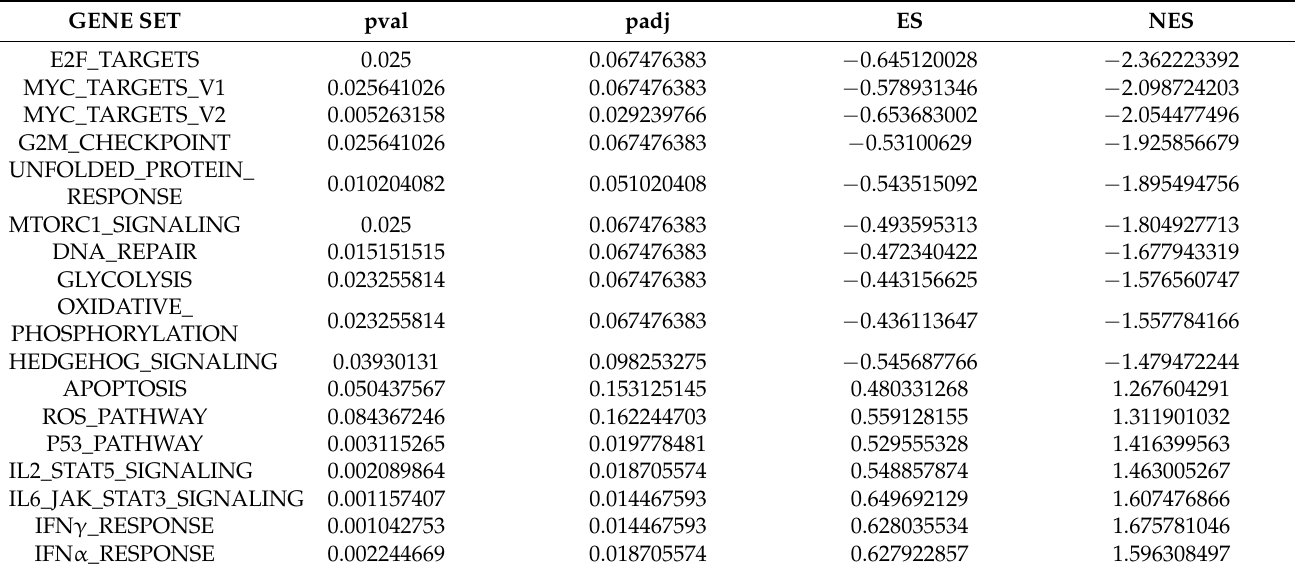
Table 3. Gene Set Enrichment Analysis (GSEA) querying Hallmark database of DE target genes in melanoma patients expressing high miRNA-181a and -181b versus